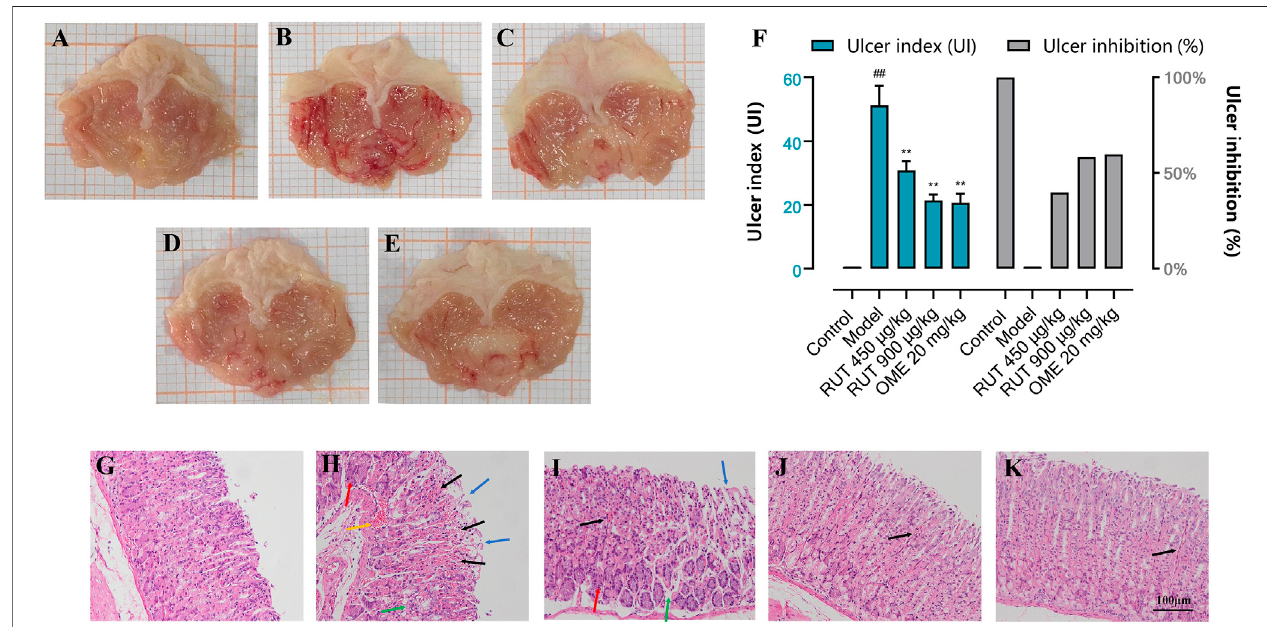
FIGURE2| EffectofRUTonethanol-inducedgastricmucosainjuryinmiceindifferentgroups.Note: (A – E) Macroscopicrepresentativeimages; (F) Ulcerindexand ulcer inhibition; (G – K) Microscopic representative images (H&E stained, × 200 magni fi cation; Scare bar: 100 μ m. Blue → : loss of gastric epithelial cells; Black → : hemorrhagic injury; Yellow → : vascular congestion; Green → : edema; Red → : in fl ammatory cells in fi ltration). (A,G) Normal control group; (B,H) Model group; (C,I) RUT 450 μ g/kggroup; (D,J) RUT900 μ g/kggroup; (E,K) OME20 mg/kggroup.Valuesareexpressedasmean ± SD(n (cid:1) 8).# p < 0.05and## p < 0.01whencompared with the control group. * p < 0.05 and ** p < 0.01 when compared with the model group.